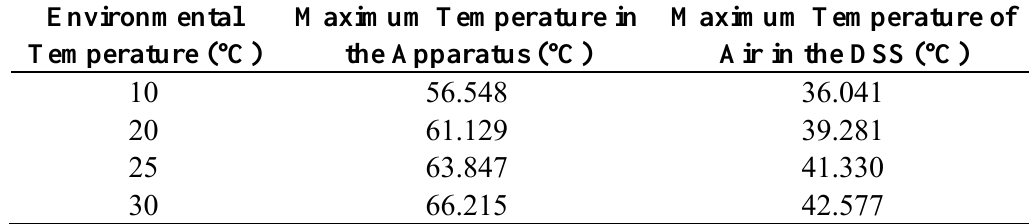
Table 4. Maximum temperature inside the apparatus and the substation with different environmental temperature (distance between apparatus and wall is 5 m, wind velocity is